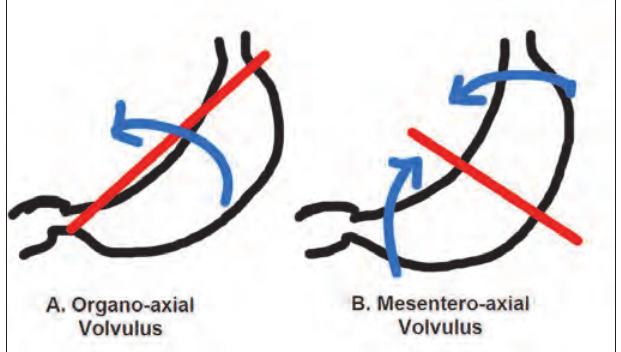
Fig. 4. Sketch demonstrating the mechanism of both (a) organoaxial and (b) mesenteroaxial volvulus. In (a), organoaxial volvulus develops secondary to twisting of the stomach along its long axis (red line). In (b), there is rotation of the stomach around the short axis (red line) resulting in mesenteroaxial